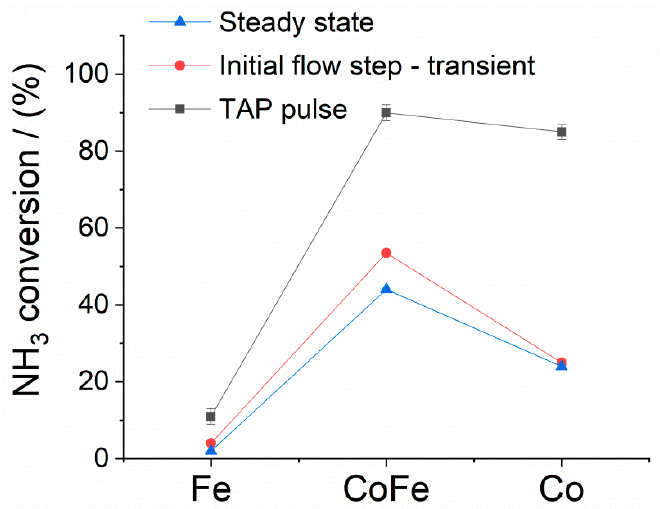
Figure 2. Ammonia % conversion in decomposition experiments at 550 °C in steady-state flow, the onset of the flow step-transient and temporal analysis of products (TAP) pulse response experiments for Fe, CoFe and Co.